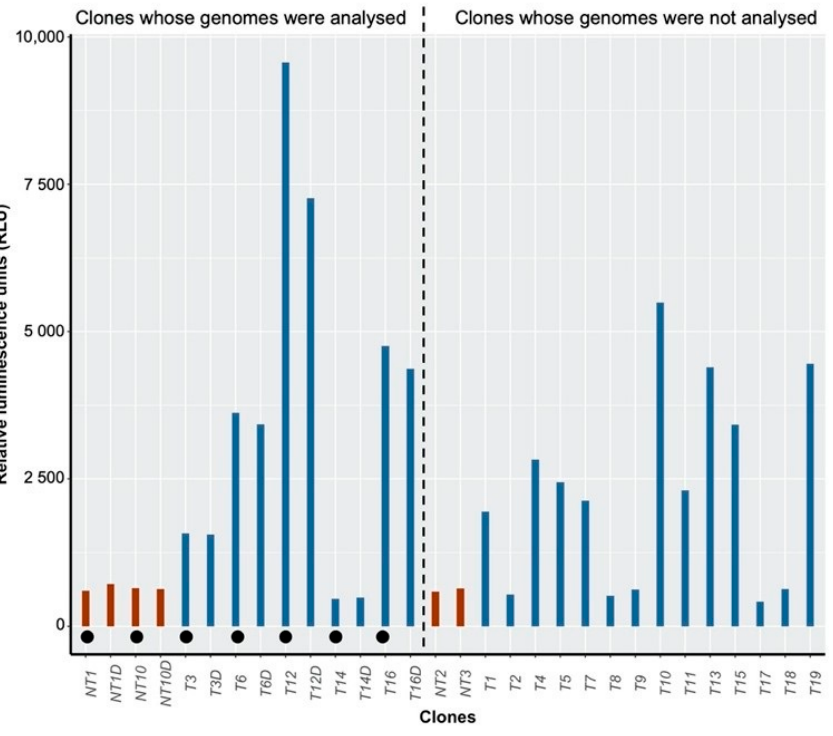
Figure 5. Firefly luciferase assay of transgenic clonal lines. Emission of light measured expressed in relative luminescence units (RLU) from 19 transformed clonal lines (blue bars) and 4 untransformed clonal lines as a control (red bars). The stability of the vector within the host genome was analyzed in the 7 lines studied in this study by measuring the fluorescence emitted from samples (NT1D, NT10D, T3D, T6D, T12D, T14D, T16D) thawed 6 months after transformation. Clonal lines studied in this work are distinguished by filled black circles. Raw data are available in Table S4. Each sample was measured once.